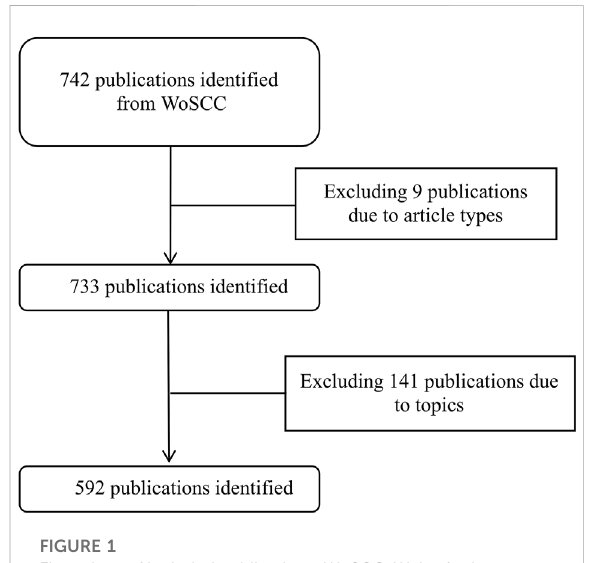
FIGURE 1 Flow chart of included publications. WoSCC, Web of science center.